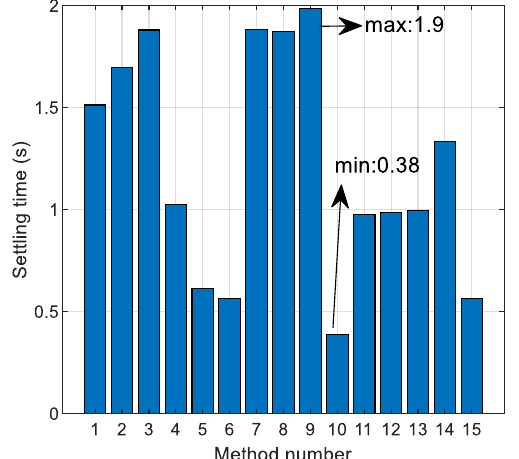
Figure 7. Settling time for each method from Table 3.